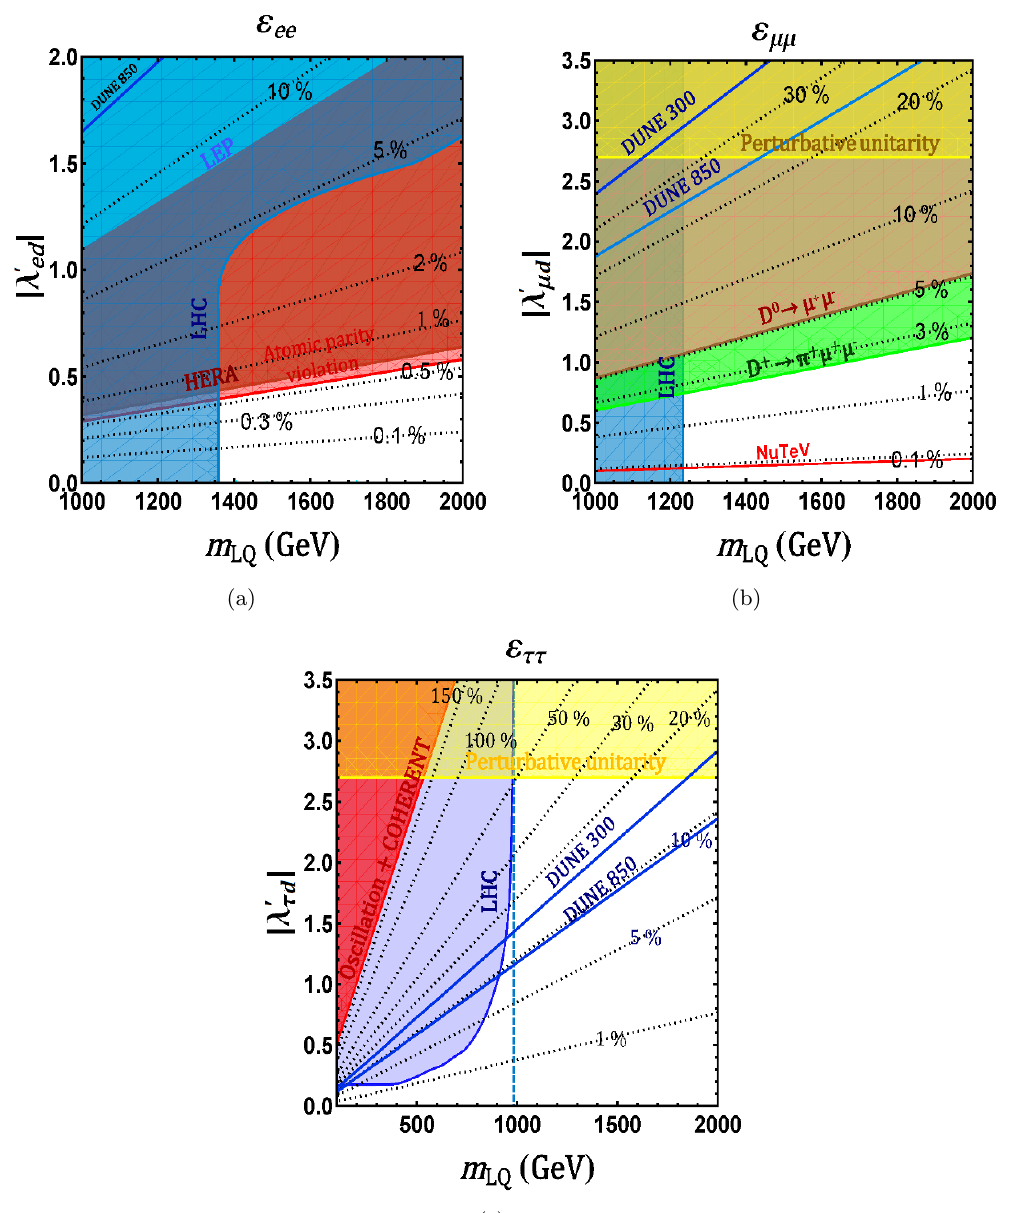
Figure 35 . Predictions for diagonal NSI ( " ee ; " (cid:22)(cid:22) ; " (cid:28)(cid:28) ) induced by the triplet LQ are shown by black dotted contours. Color-shaded regions are excluded by various theoretical and experimental constraints. The labels are same as in (cid:12)gure 31.